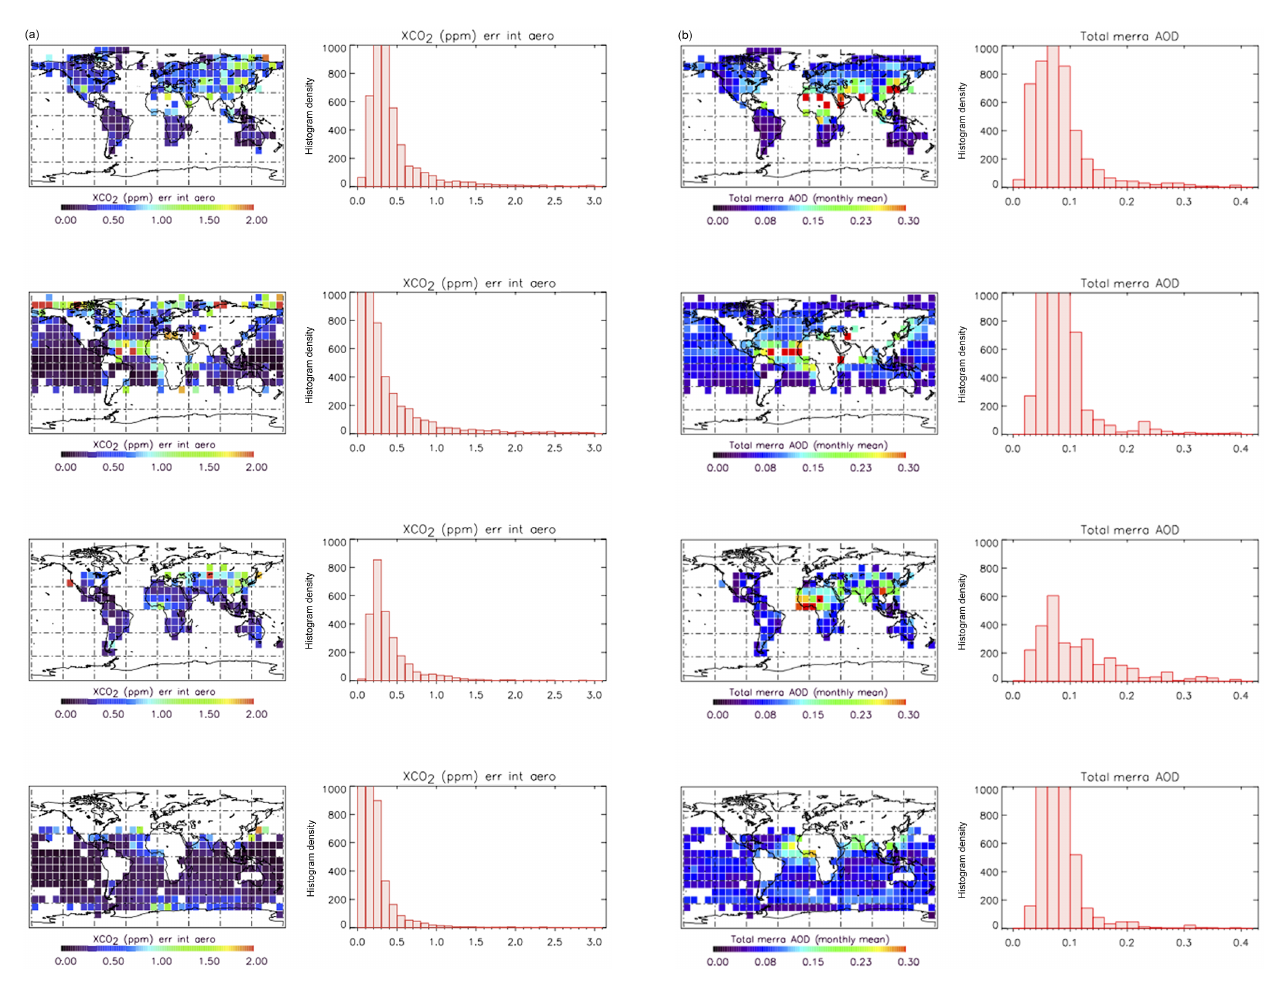
Figure 4. (a) Aerosol error. Top: June, land; second row: June, ocean; third row: Dec., land; bottom: Dec., ocean.